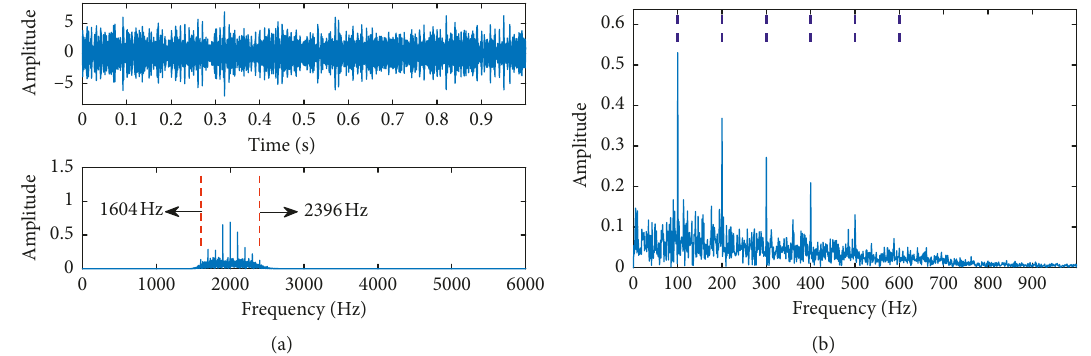
Figure 12: (a) Time-domain waveform diagram of the signal component with the maximum kurtosis found by the new method and its frequency band and (b) its envelope sequence.